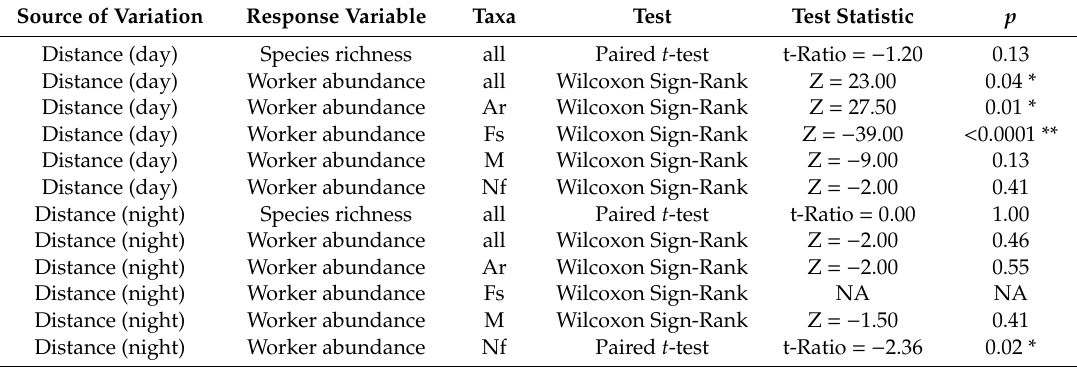
Table 4. Di ff erence in resource use of dominant (Fs) and non-dominant ant species near and far from nests of F. subsericea .